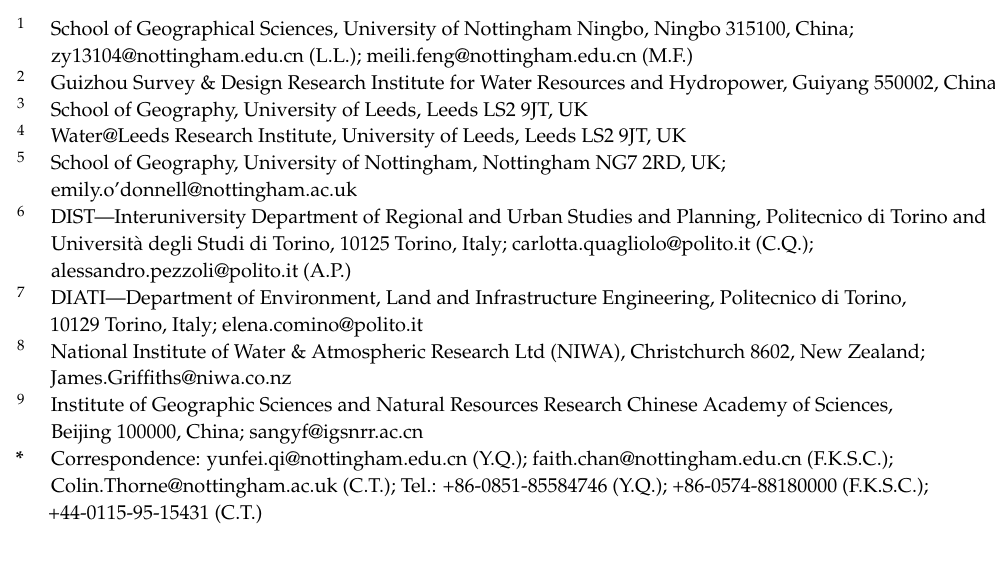
**Figure 5. NBS integrates the grey and green to create hybrid approaches. Closely adapted from